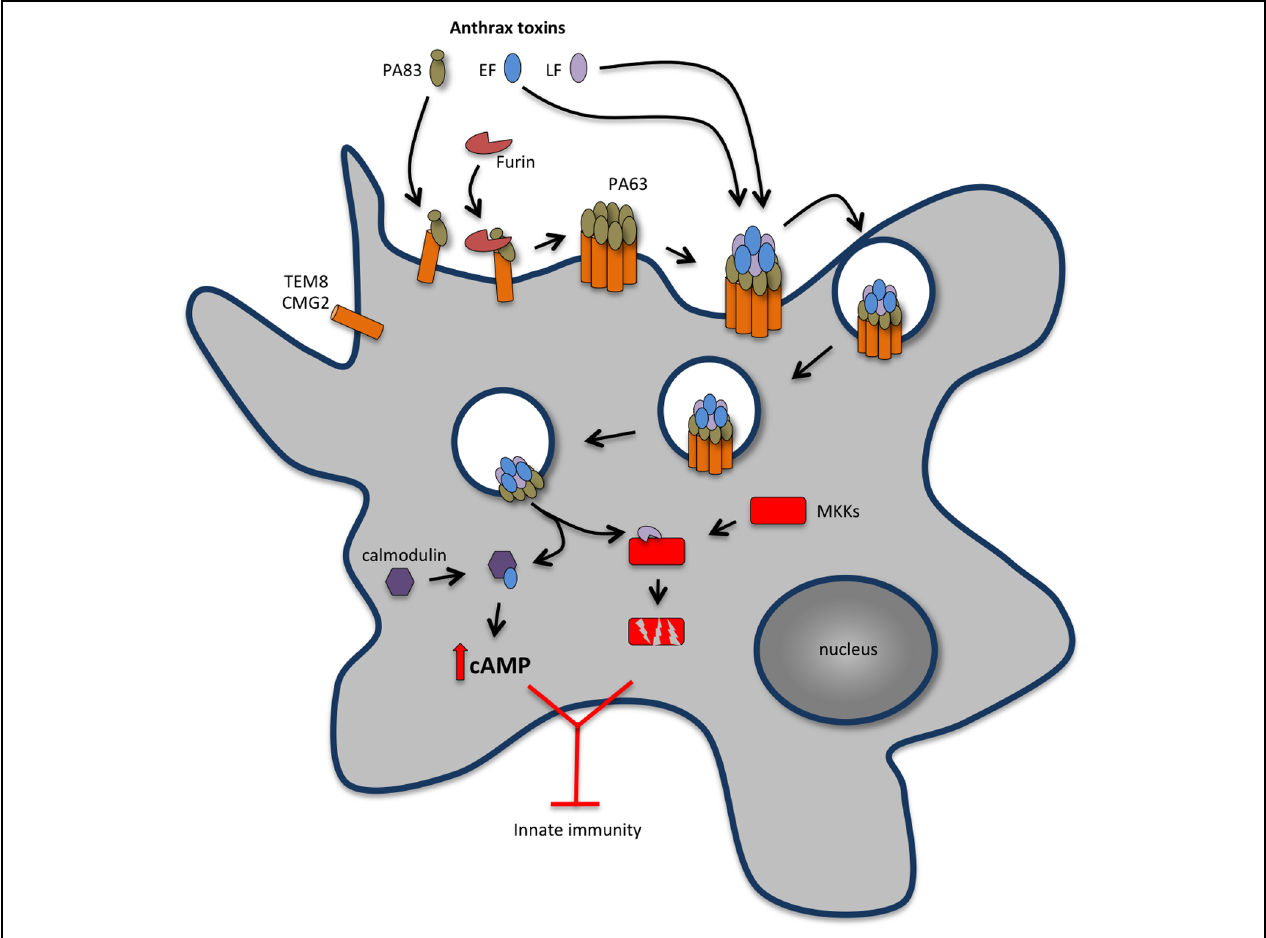
FIGURE 2 | Anthrax toxins cooperatively disable host innate immune response. Host cell intoxication by anthrax toxins involves interaction of protective antigen (PA, 83 kDa) with two cellular receptors [tumor endothelium marker 8 (TEM8), also known as anthrax toxin receptor 1 (ANTXR1) and capillary morphogenesis protein 2 (CMG2) also known as anthrax toxin receptor 2 (ANTXR2)], which are expressed by different cell types, including macrophages and neutrophils. Upon binding to the cell surface receptor, PA83 is proteolytically processed at its N-terminus by a furin-like protease yielding the C-terminal fragment PA63 that oligomerises into a heptameric prepore able to bind edema factor (EF) and lethal factor (LF). The EF and/or LF-prepore-receptor complex undergoes receptor-mediated endocytosis and the acidic conditions in endosomes induce conversion of the prepore to a pore, allowing translocation of EF and LF into the cell cytosol to exert their cytotoxic effects. LT is a zinc-dependent metalloprotease that inhibits activation of neutrophils and macrophages, expression of inflammatory cytokines and cell motility by disrupting mitogen activated protein kinase kinases (MAPKKs)-regulated pathways. LT activity also promotes macrophage apoptosis by interfering with pro-survival MAPKK dependent pathways. ET is a calcium and calmodulin-dependent adenylate cyclase that increases intracellular cAMP concentration, leading to the suppression of the expression of inflammatory cytokines and cell chemotaxis through protein kinase A (PKA)-dependent pathways. The concerted action of LT and ET blocks the function of phagocytic